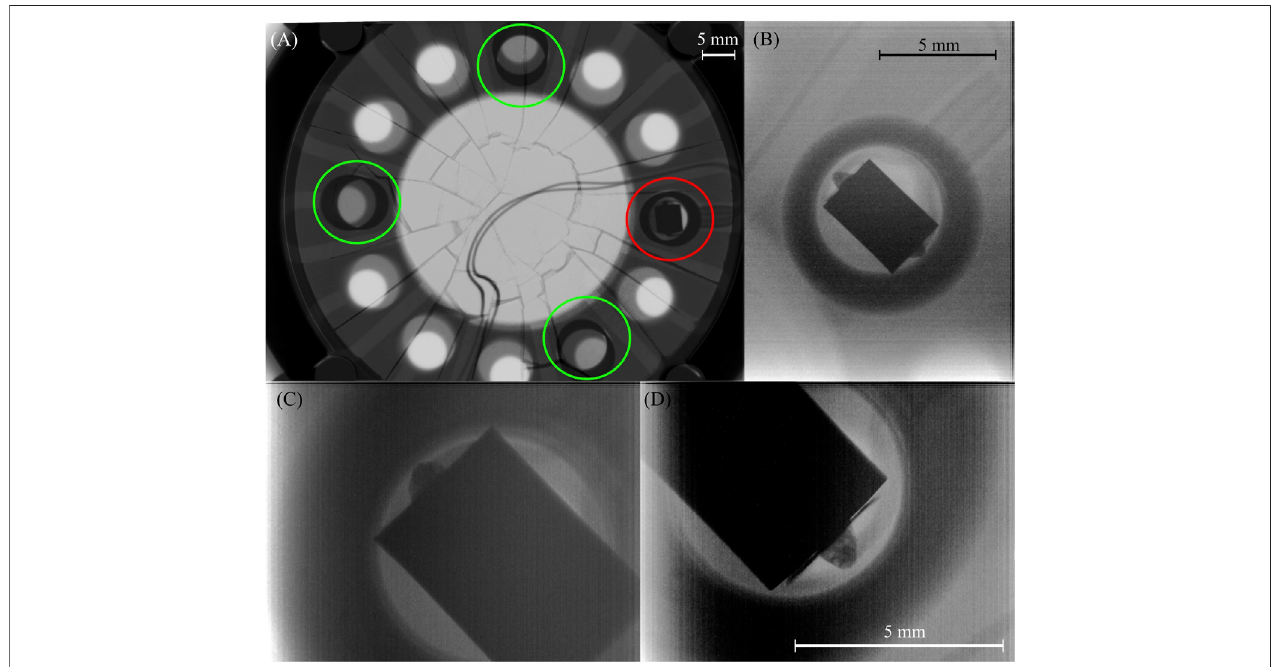
FIGURE 8 | High-resolution x-ray images showing wire-bonding for the actuator on Test article #2. (A) Top x-ray image of the canister. The red circle indicates the piezoactuatorplacement.Thegreencirclesindicatethemockactuatorplacements. (B) Close-upx-rayimageofthepiezoactuator. (C,D) Close-upimagesshowingthe wire bonding on each side of the piezo-element stack.